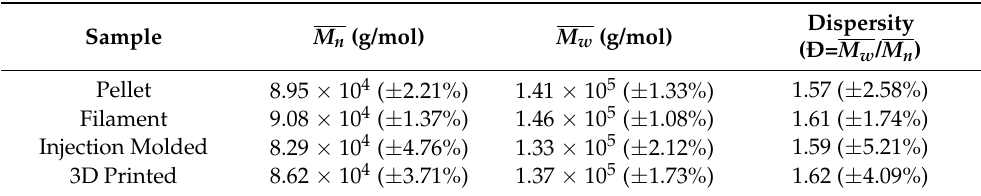
Table 3. Number ( M n ) and weight ( M w ) averaged molecular weights and dispersity index (Ð) for pellet and processed PMMA samples.